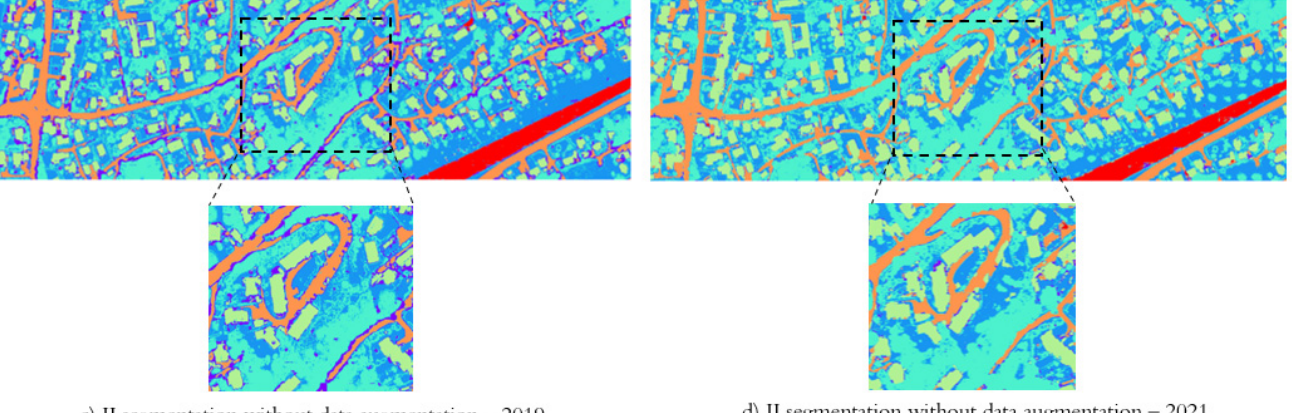
Table 3. Segmentation results with data augmentation for the dataset from 2019 and 2021 for the ResU-Net model based on MCC calculated for each class (the range scales from − 1 to 1) and overall F1 score (the range scales from 0 to 1). Color